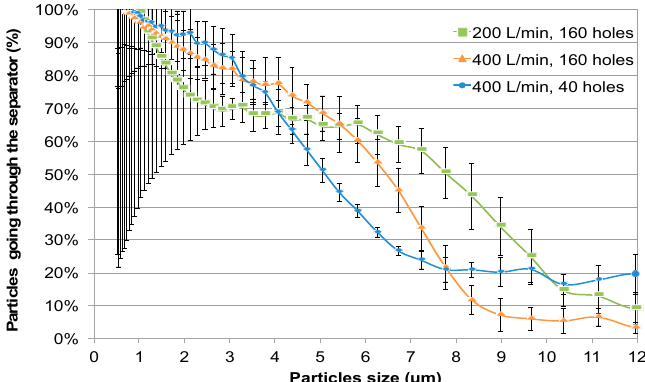
Figure 6. Particle separator D 50 measurement as a function of airflow and the number of separator orifices used. Comparison of particle distribution in cage three with and without a particle separator, as measured with an aerodynamic particle sizer (APS) located at 2” from the particle separator.